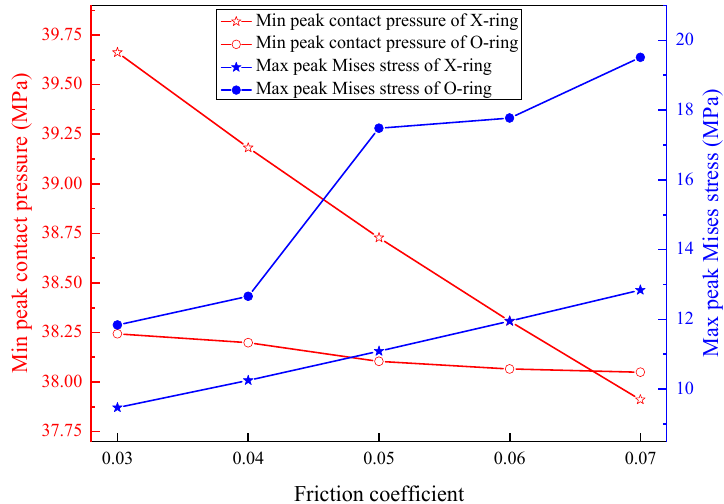
Figure 11. Min peak contact pressure and Max peak Mises stress of X-ring and O-ring at various C f during 1–2 T.